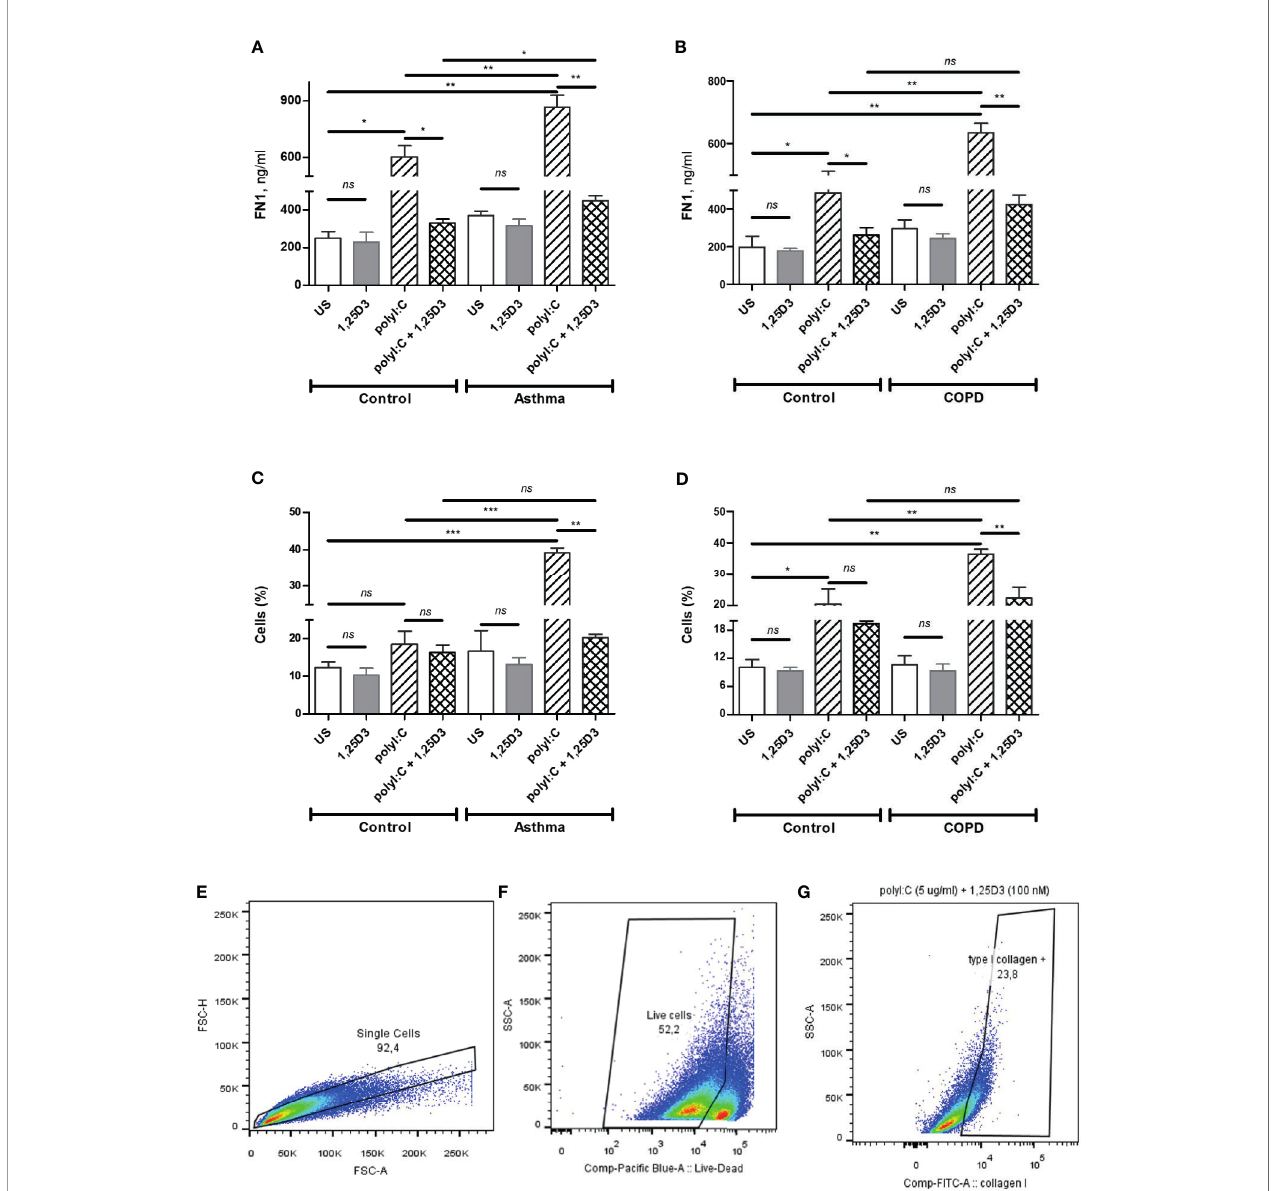
FIGURE 6 | Protein levels of FN1 in BSMCs from asthma (A) and COPD (B) compared to BSMCs from healthy control groups were quanti fi ed by ELISA. Flow Cytometry was used to quantify intracellular levels of type I collagen in BSMCs from asthma (C) and COPD (D) groups. Graphic quantitation, % of type I collagen positive BSMCs populations using GraphPad (C, D) . Gating strategy of type I collagen positive BSMCs: (E) Exclusion of doublet events. (F) Exclusion of dead cells. (G) Gating of type I collagen positive BSMCs. The number of cells (%) included in each gate is indicated in each panel. n = 4 asthma, n = 3 healthy controls, n = 4 COPD, and n = 3 healthy control smokers. Data is representative of two independent experiments. One way ANOVA using Newman-Keuls multiple comparison test were performed to assess statistical signi fi cance between groups. Mean ± SE; ( ns ) p > 0.05, no signi fi cant difference, * p < 0.05, ** p < 0.01, *** p <